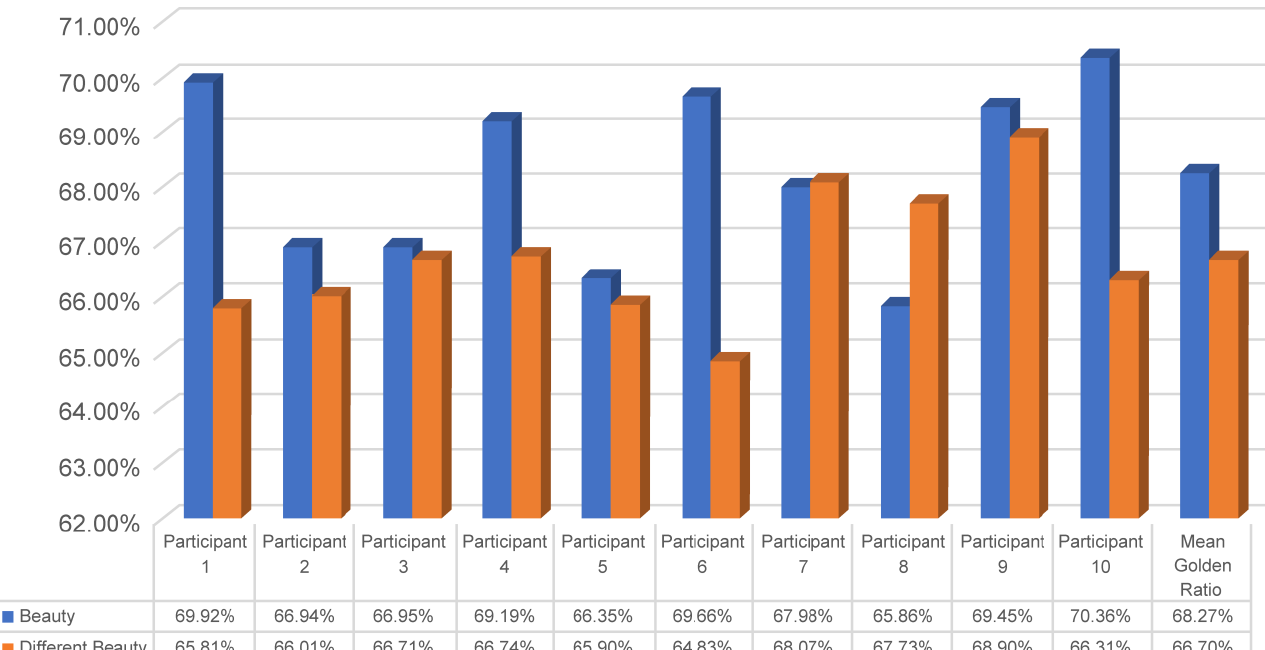
Figure 10. Mean of total golden ratio for both classes.